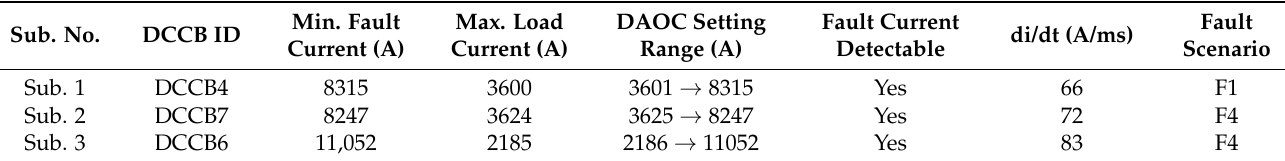
Table 15. Track feeder protection